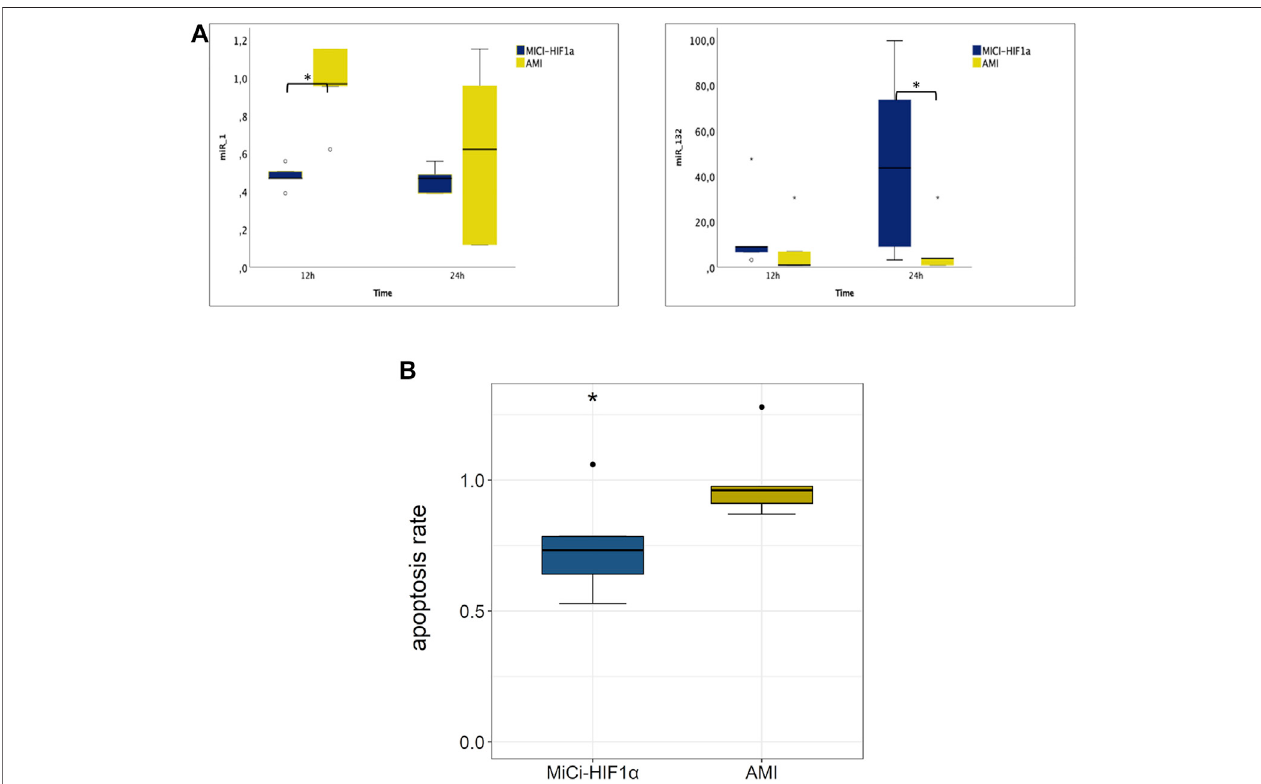
FIGURE 5| Myocardial expression of miRNAs in plasma 12 and 24 h and apoptosis 1 month after intramyocardial injection ofporcineMSC transfected with MiCi- HIF1 α into the border area of chronic infarction, compared to non-treated infarcted heart. (A) miR-1 and miR-132 expression levels are represented relative to healthy controls (relative expression 1.0 for each) with normalization to the reference let7a. Myocardial samples were collected from the border zone of infarction 12 and 24 h after injection of pMSC-MiCi-HIF1 α n = 5. Statistics: test-test, *: p < 0.05. (B) Relative changes in apoptosis rate in pMSC-MiCi-HIF1 α treated animals compared to those without treatment at the 1-month follow-up. Apoptosis was assessed by determination of caspase-3 in histological slices. n = 5. Statistics: t-test, **: p < 0.01, *: p <